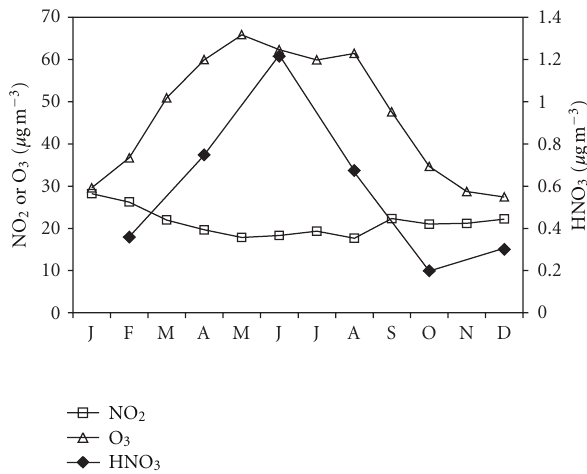
Figure 9: Seasonal cycle of nitric acid and two of its precursors during 2008/09.